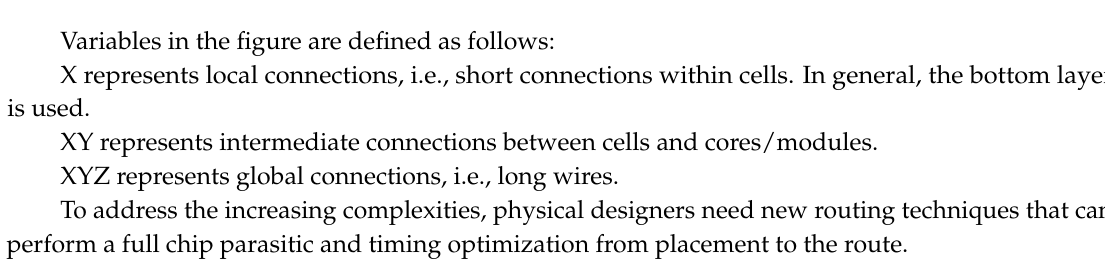
Figure 2. Critical path and delay sensitivity. Reproduced with permission from [7], IEEE, 2016.